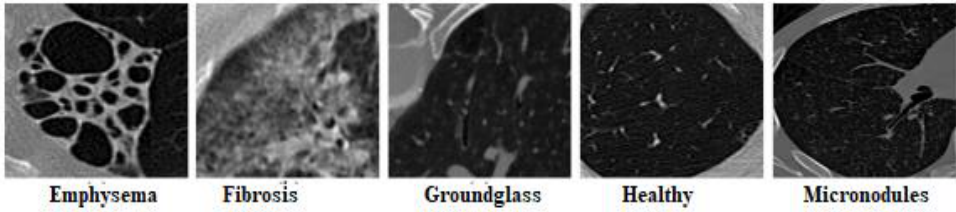
Figure 10. Sample images from five classes of ILD database. Table 5. Retrieval Accuracy (ARP) in percentage on ILD